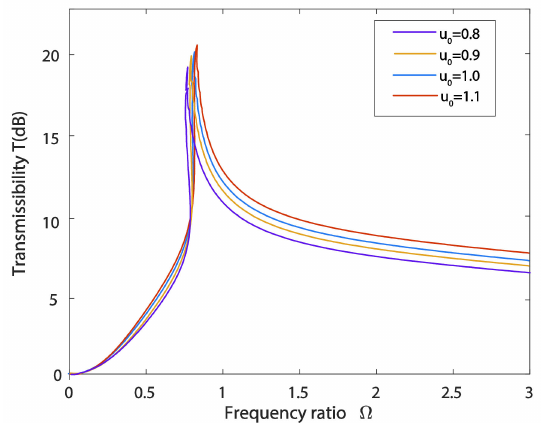
Figure 14. The absolute displacement transmissibility of the QZS-IE seat suspension system with different excitation amplitudes ( µ = 0.4, λ = 0.2, ζ = 0.05, ε = 2).